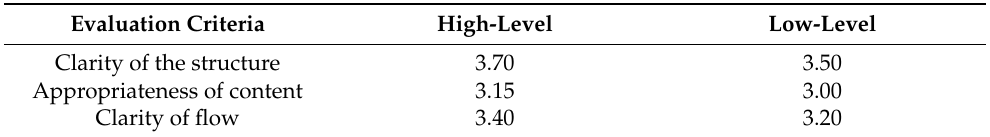
Table 1. Mean value of clarity and appropriateness of the conceptual high-level and low-level BC-HTD framework (responses of industry experts and